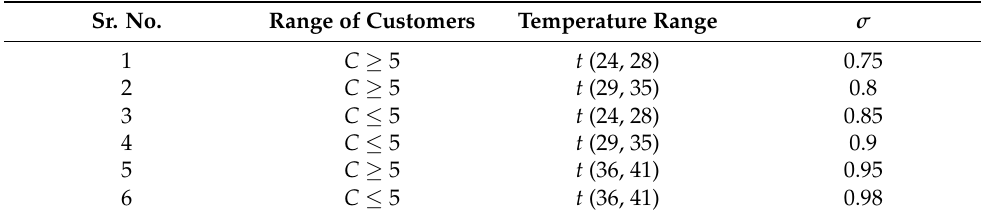
Table 2. Selection of σ . Sr.